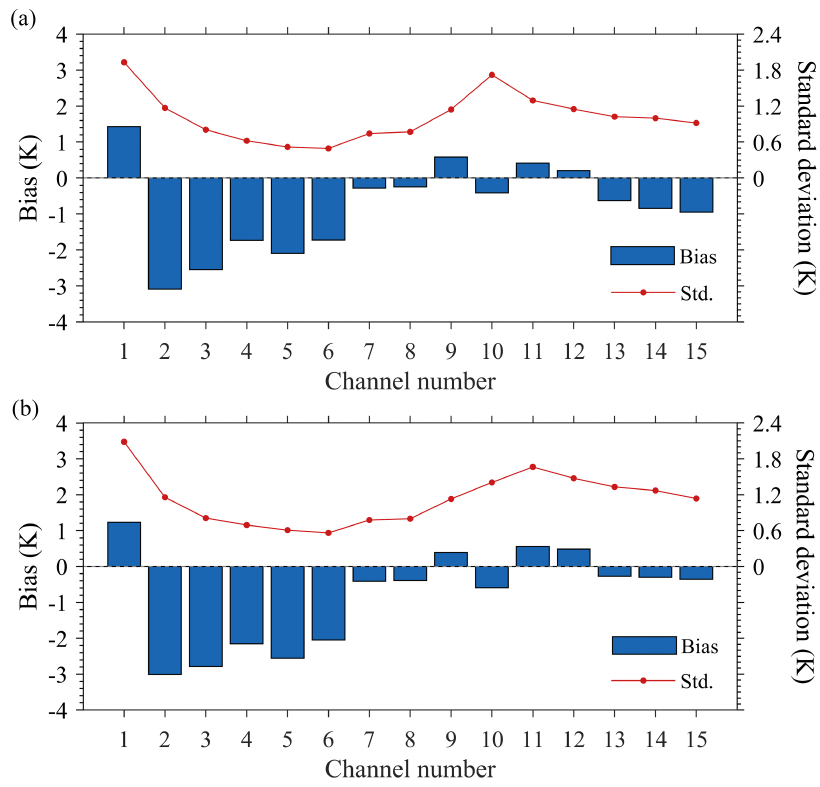
Figure 5. Biases (blue bars, unit: K) and standard deviations (red dotted curves, unit: K) of the “O − B” calculated from clear-sky marine pixels based on the background field of: ( a ) ERA-5; and ( b ) NCEP FNL, respectively. The calculation covers the period from 24 September to 8 October